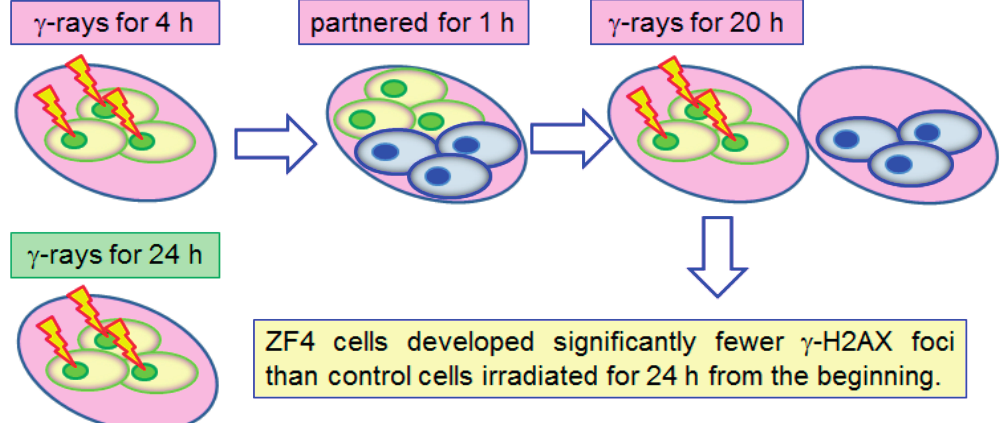
Figure 2. Comparison of γ -H2AX foci developed on embryonic zebrafish (ZF4) cells upon two different treatments: Top row: gamma radiation for 4 h, then partnered them with non-irradiated bystander ZF4 cells for 1 h, and finally irradiated with gamma radiation for another 20 h; bottom row: gamma radiation for 24 h. Treatment in the top row led to significantly fewer γ -H2AX foci than treatment in the bottom row.